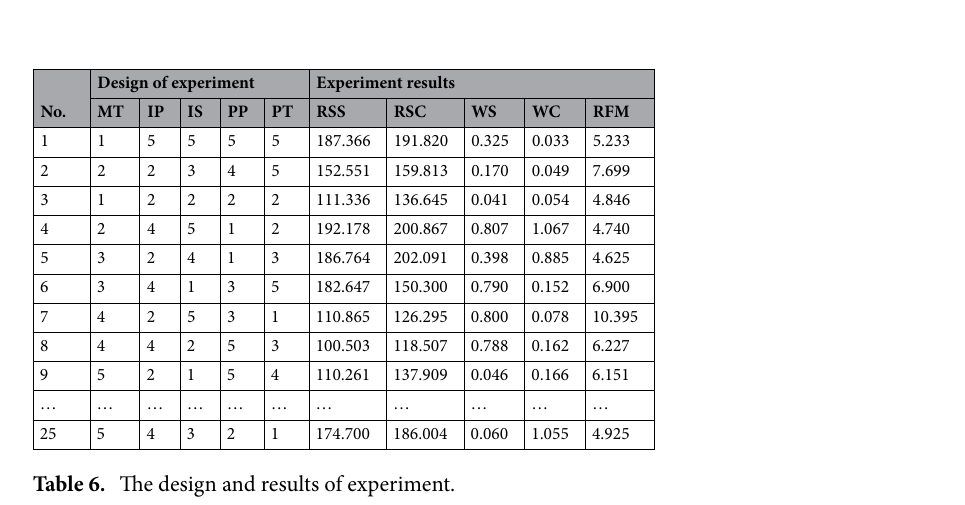
Table 5. The range of process parameters on injection molding for protein electrophoresis microfluidic chip.